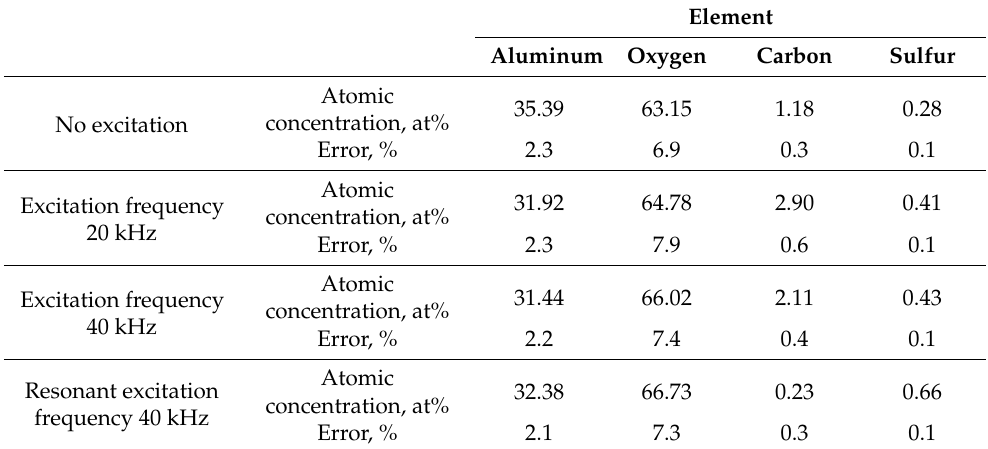
Figure 6. Images of the thickness of the AAO membrane when the membranes were fabricated un ‐ der different anodization conditions: ( a ) no frequency excitation; ( b ) excitation at 20 kHz; ( c ) excita ‐ tion at 40 kHz; ( d ) resonant frequency excitation at 40 kHz. The chemical compositions of the nanoporous AAO membranes are shown in Table Table 4. Chemical composition of AAO nanoporous membranes. 4. Table 4. Chemical composition of AAO nanoporous membranes.